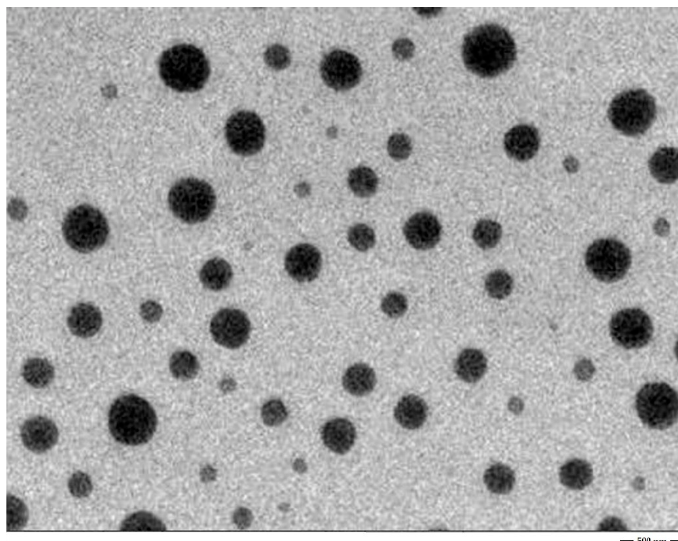
Figure 6. TEM images of optimized FX-loaded SLNs